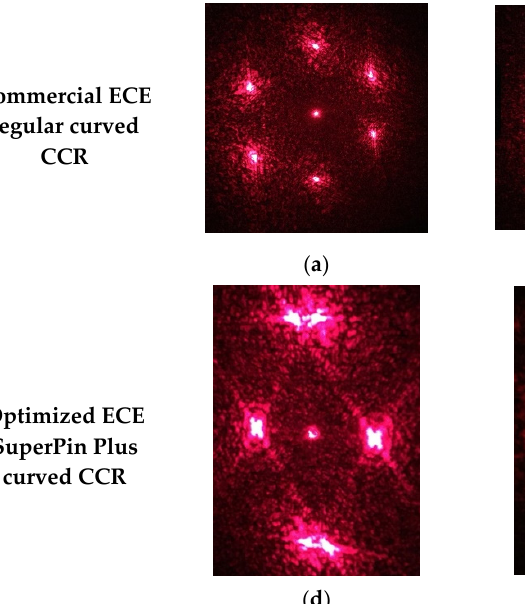
Figure 18. The intensity distributions on anterior, central, and posterior regions, which are shown in: